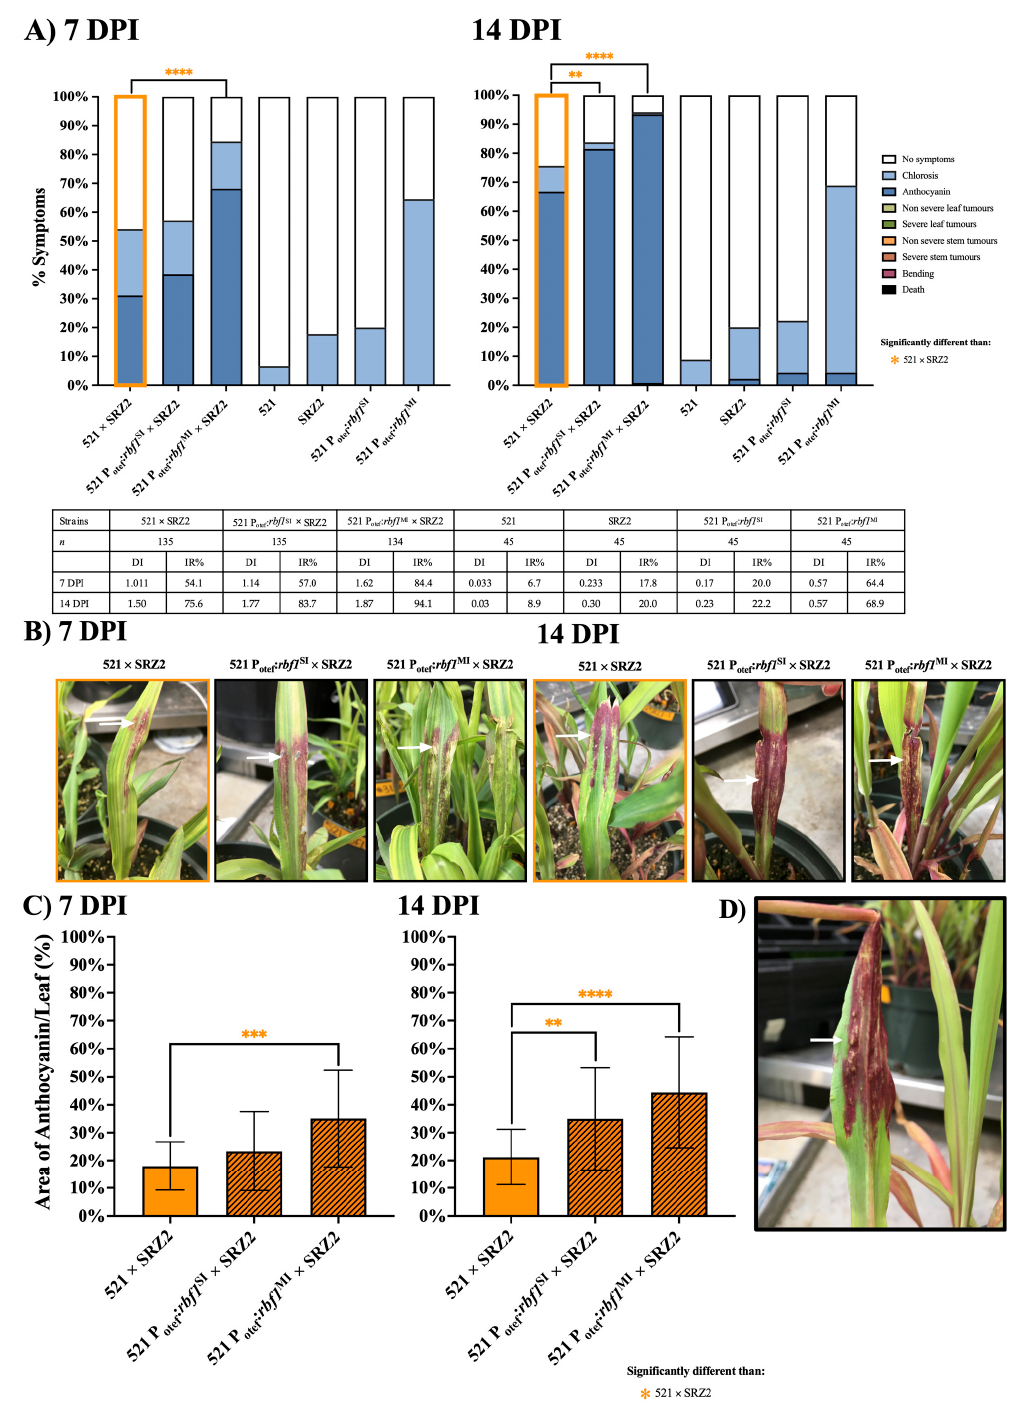
Figure 6. Hybrids constitutively expressing rbf1 induced greater anthocyanin than the unaltered hybrid at 7 and 14 DPI. ( A ) Colored bars represent the percentage of plants that developed a scored symptom, as indicated in the legend. The table presents the number of plants infected ( n ), disease index (DI), and infection rate (IR). ( B ) Representative symptoms, indicated by the arrows, for 521 × SRZ2 infections is anthocyanin, for 521 P otef : rbf1 SI × SRZ2 infections is anthocyanin, and for 521 P otef : rbf1 MI × SRZ2 infections are anthocyanin + chlorosis. ( C ) The percent (%) of leaf surface area in which anthocyanin was induced was quantified using ImageJ software. Three separate experiments were conducted, and the combined results are presented. Statistical differences were calculated comparing the hybrid to each parental dikaryon (** = p < 0.01; *** = p < 0.001; **** = p < 0.0001). ( D ) Leaf tumor formation, indicated by the arrow, induced by the 521 P otef : rbf1 MI × SRZ2